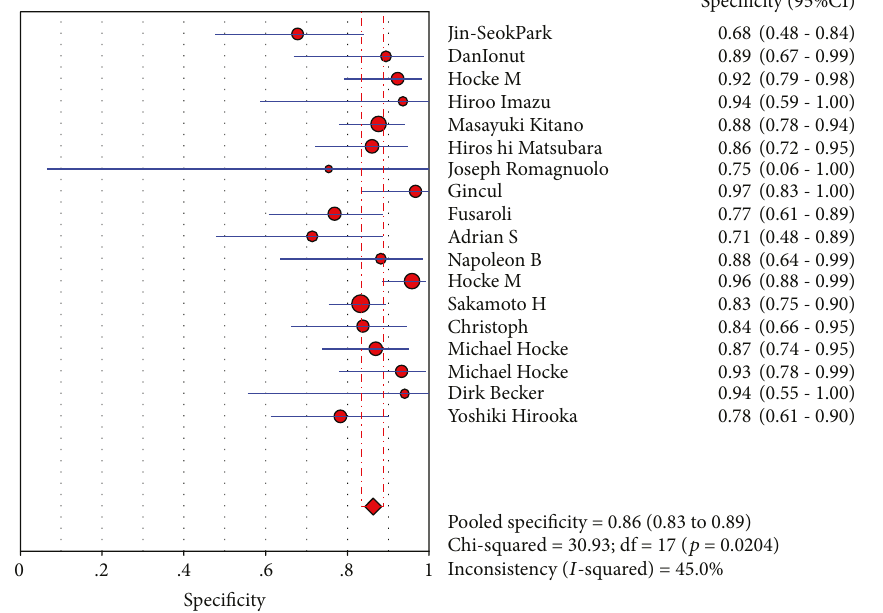
Figure 3: Speci fi city of the selected studies and this meta.